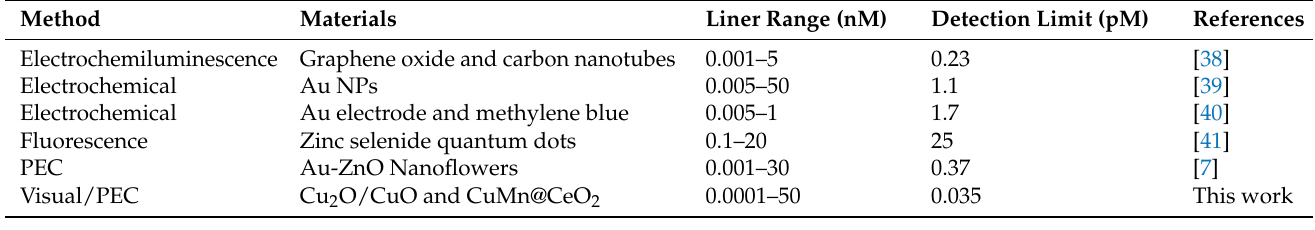
Au-ZnO Nanoflowers 0.001–30